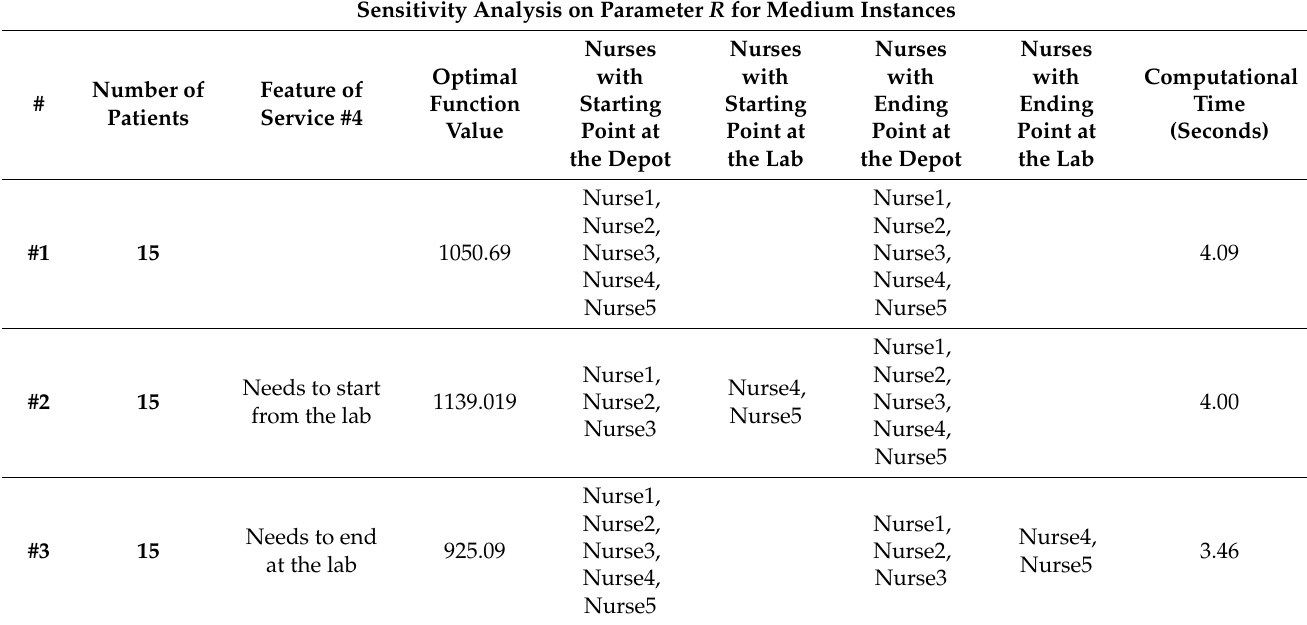
Table 9. Sensitivity analysis on parameter R for medium instances.